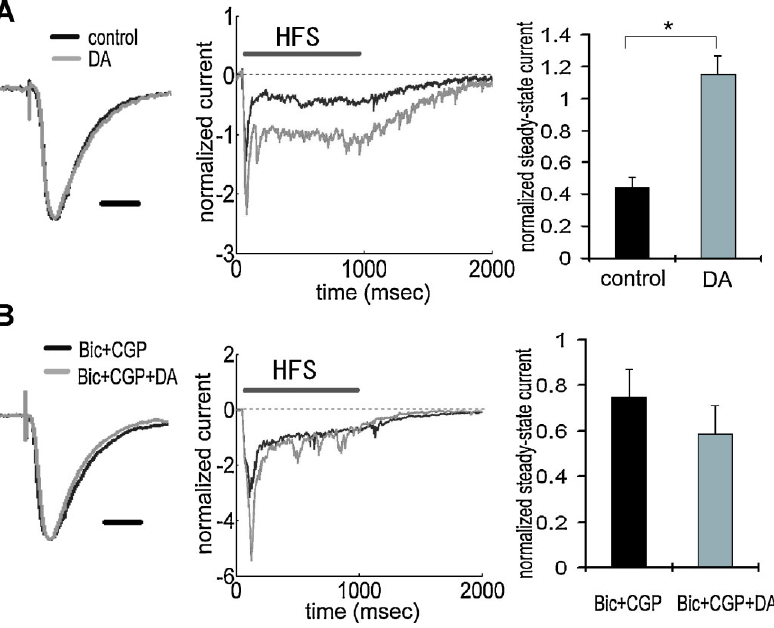
Figure 4. Enhancement of TA-CA1 synaptic efficacy during HFS via DA-induced disinhibition . ( A ) Whole-cell voltage-clamp recording from CA1 pyramidal neurons. Waveforms represent the average of all data, showing normalized baseline EPSC (left) and current during HFS (middle). There was no difference in the kinetics of EPSC waveforms obtained with or without DA application. Waveforms during HFS (100Hz 100pulses) were normalized to baseline EPSC amplitude prior to HFS, and the current at the end of HFS (100th stimulus response) was measured (steady-state current). The right figure shows the analysis of steady-state current, showing that DA induced a significantly (p<0.01) larger steady-state current. Input resistances were not significantly different (in M Ω ); control: 85.8 ± 9.3, DA: 85.0 ± 9.0 (n = 6 for each group). Scale bar = 20ms. ( B ) Same experimental procedure as A under GABA receptor blockade by bicuculline and CGP 55845A. GABA blockade attenuated the enhancement of steady-state current by DA. Input resistances were not significantly different (in M Ω ); Bic+CGP: 102.0 ± 7.9, Bic+CGP+DA: 98.0 ± 4.6 (n = 5 for each group). Scale bar =